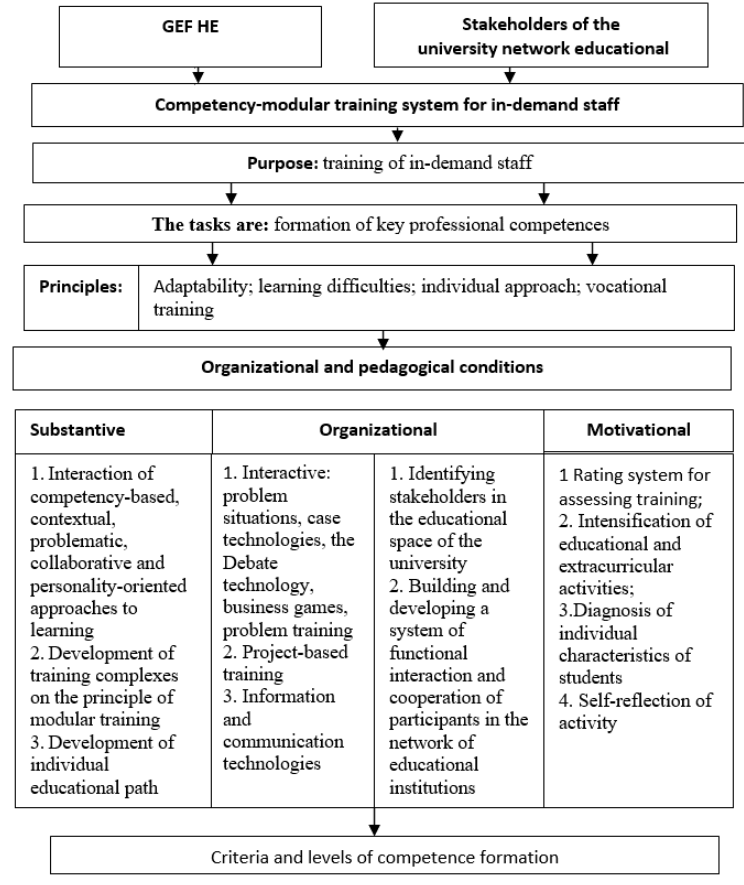
Fig. 3. Organizational and pedagogical model of in-demand staff training in the system of higher and supplementary vocational